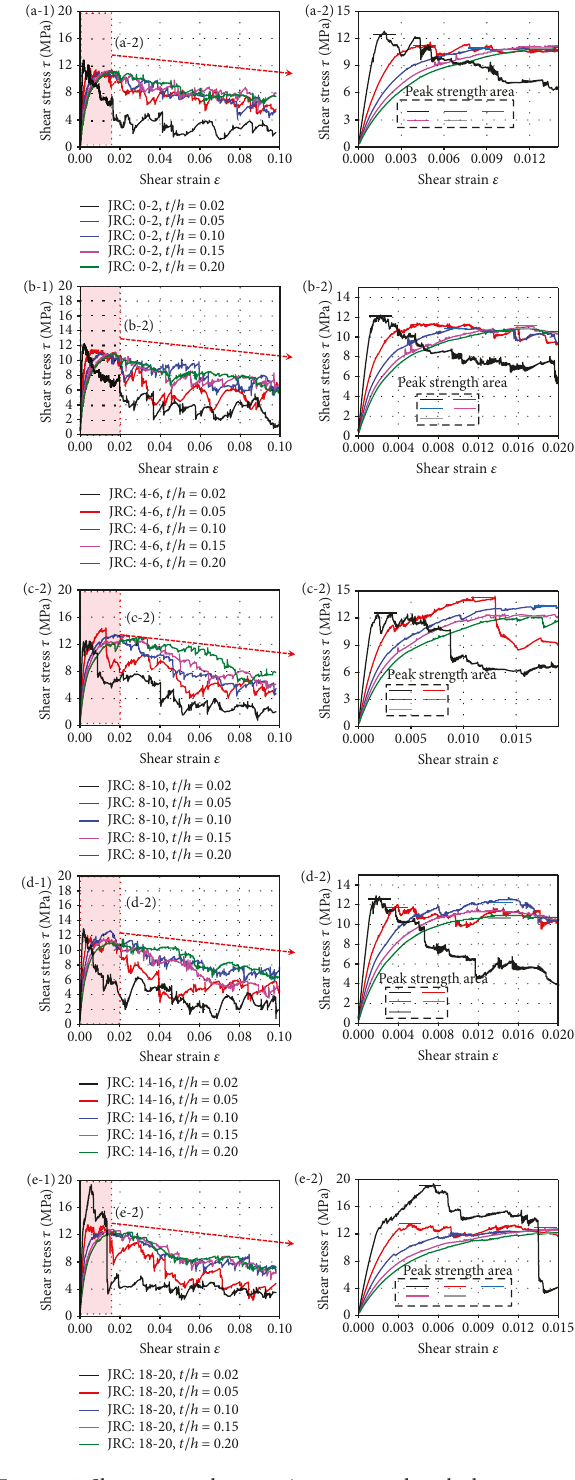
Figure 5: Shear stress-shear strain curves and peak shear strengths of simulated specimens. Panels (a-1), (b-1), (c-1), (d-1), and (e-1) are shear stress-shear strain curves of the in fi lled joints with JRCs of 0 – 2, 4 – 6, 8 – 10, 14 – 16, and 18 – 20, respectively. Panels (a-2), (b-2), (c-2), (d-2), and (e-2) are peak shear strengths of the simulated specimens derived from panels (a-1), (b-1), (c-1), (d-1), and (e-1),